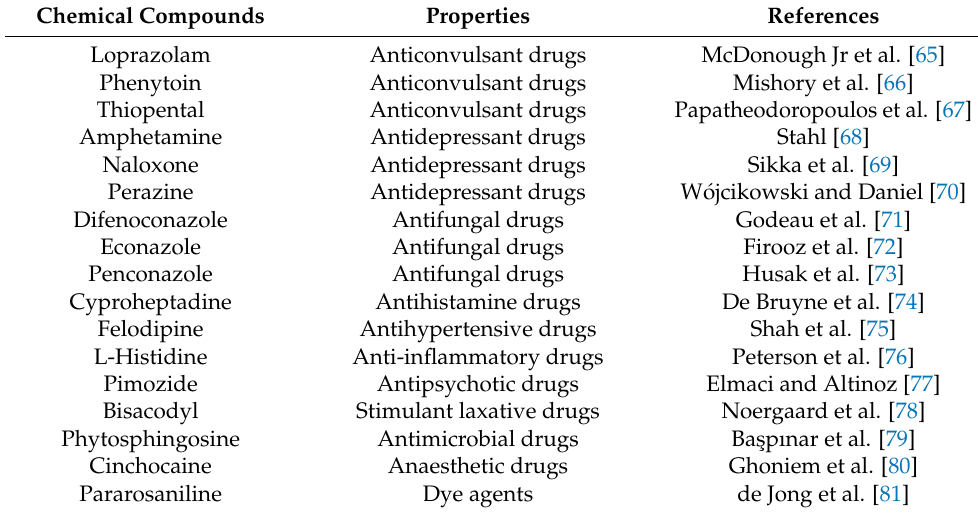
Table 11. Non-alkaloid compounds with their